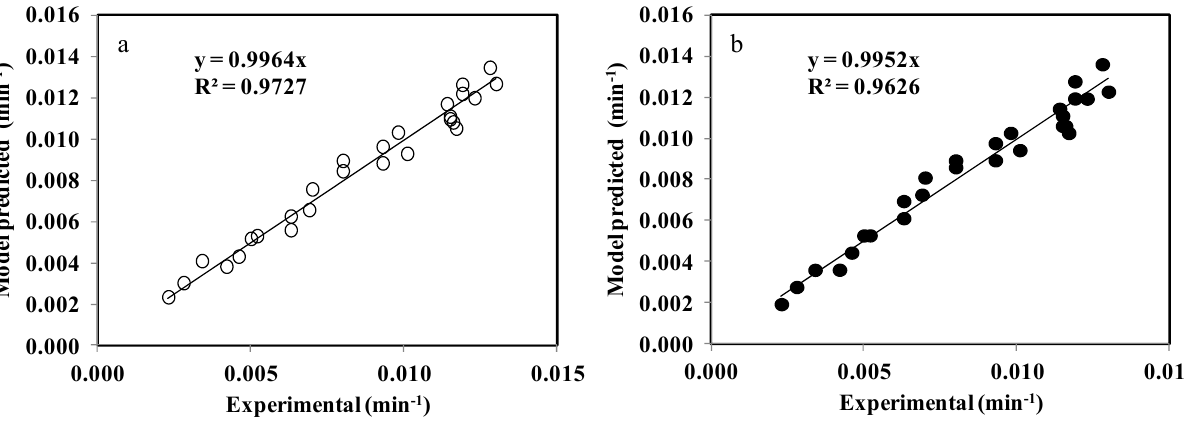
Figure 7. Predicted versus experimental degradation rate constants. ( a ) Based on Equation (5); ( b ) Based on Equation (6).